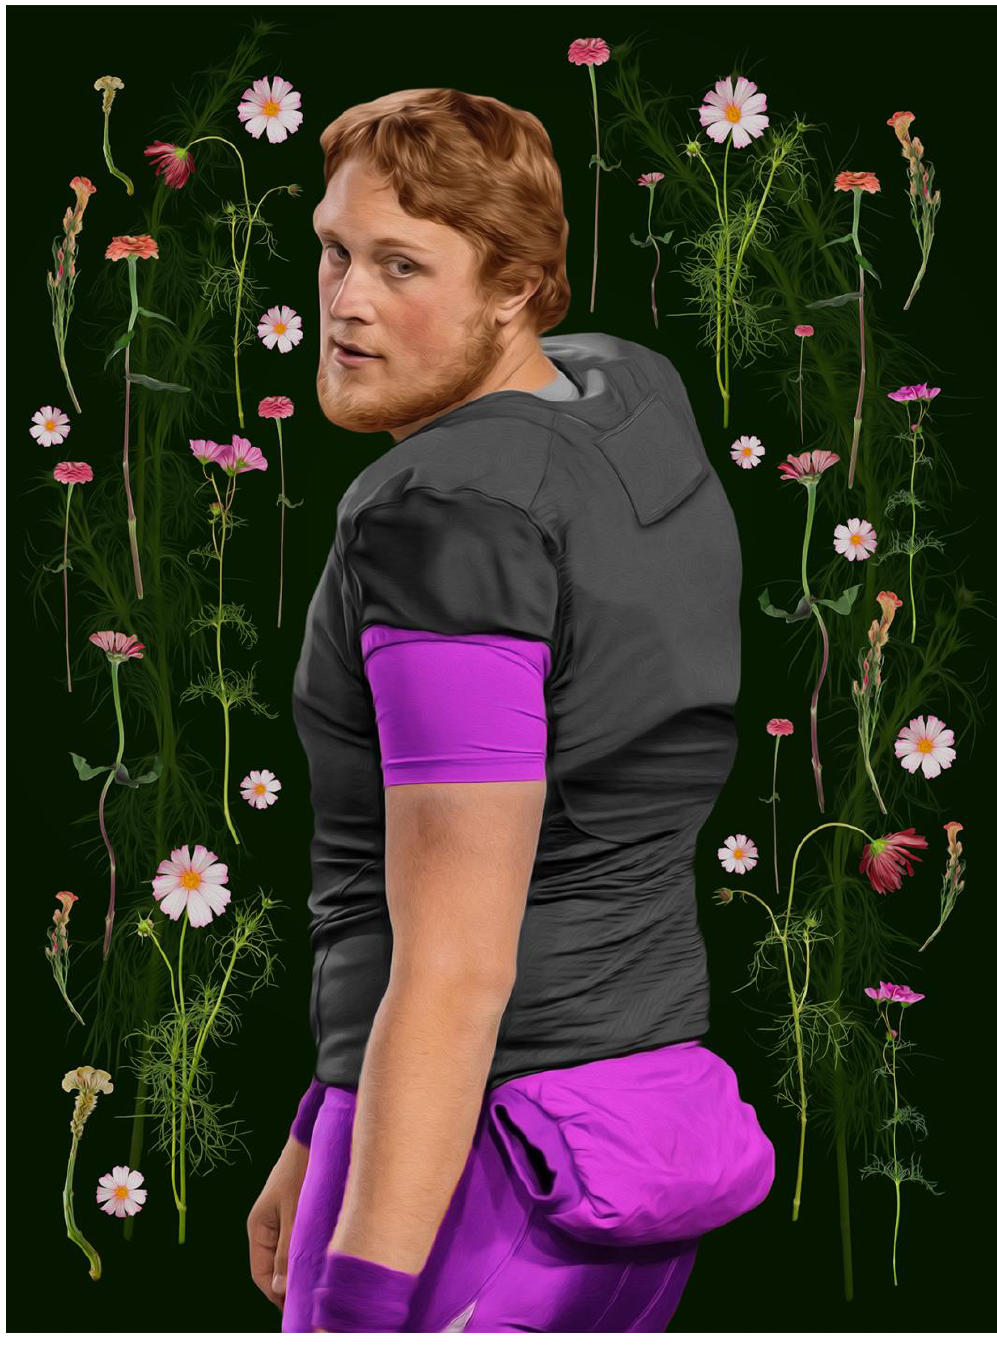
Nick Simko, Football (10) , 2018, Digital Composite Photograph, Inkjet Print on Paper, 58 x 41 ¾